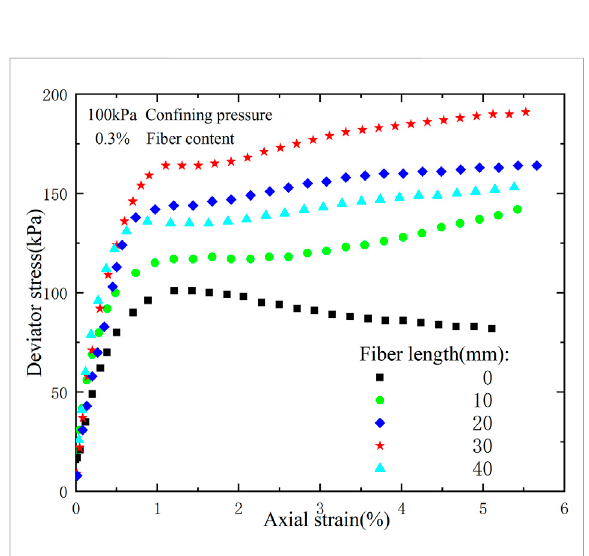
FIGURE 4 Effect of fi ber length within 0 – 40 mm on stress-strain of samples at constant con fi ning pressure and fi ber content.